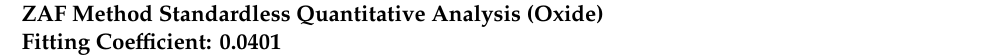
Table 7. Oxide of Hemp ( Bohmeria nivea ).